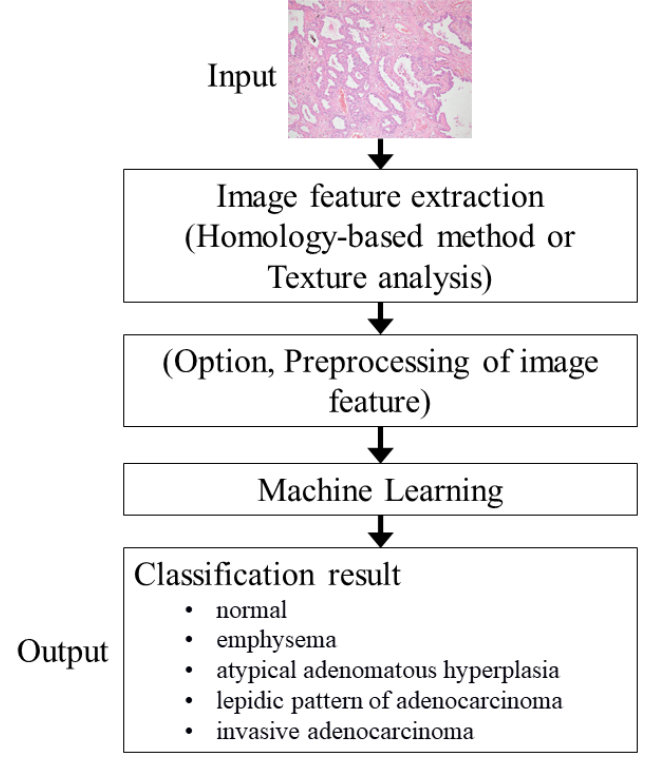
Figure 3. Outline of the CAD system in private dataset. Note: Except the output, the same processing was performed for the public dataset. CAD, computer-aided diagnosis.